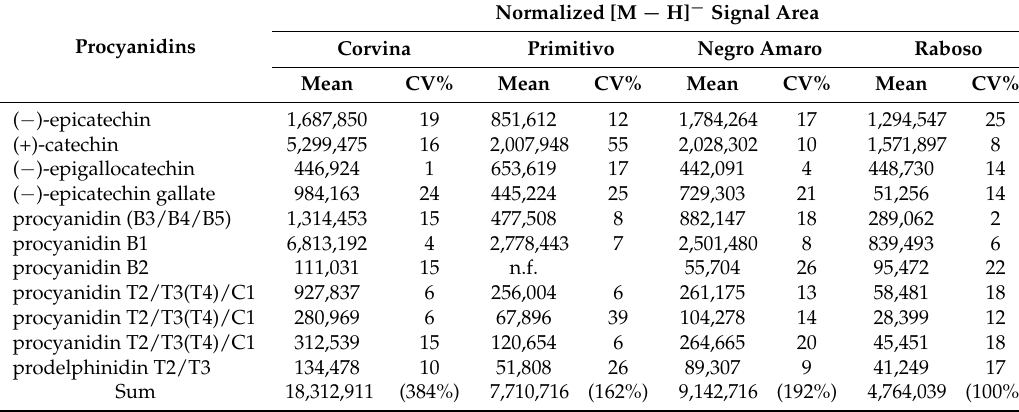
Table 3. Normalized UHPLC-Q/TOF signal intensities of flavan-3-ols and procyanidin dimers and trimers identified in the berries removed by the seeds of the four grape varieties. CV%, coefficient of variance (SD × 100/mean, n = 4). In the last line, the percentages of total signal normalized to Raboso Piave are reported in bold. n.f., signal not found. Normalized [M − H] − Signal Area Procyanidins Corvina Primitivo Negro Amaro Raboso Mean CV% Mean CV% Mean CV% Mean